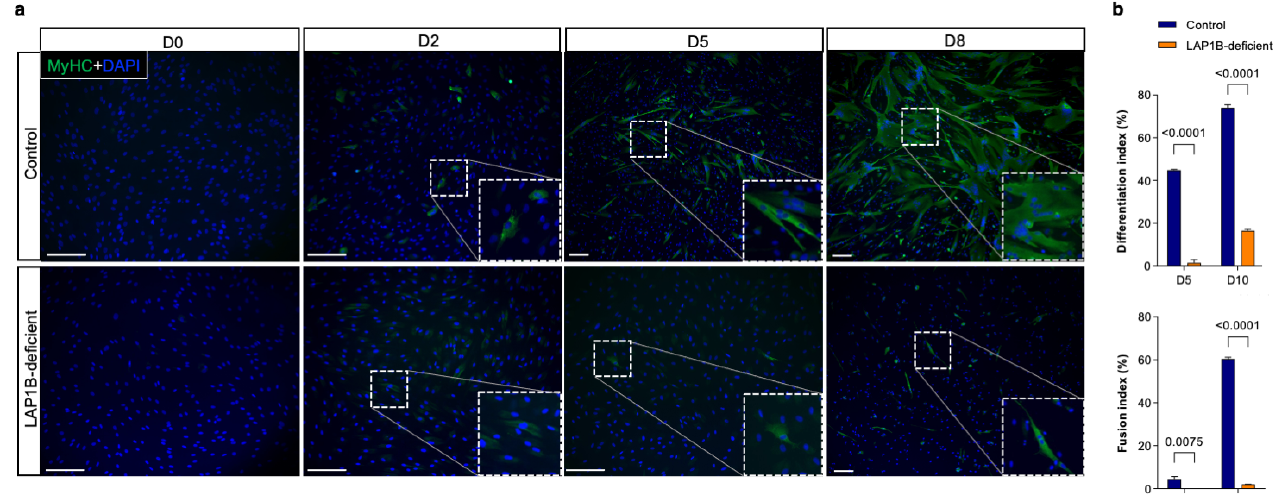
Figure 2. Myogenic differentiation of the control and patient-derived LAP1B-deficient fibroblasts. ( a ) Immunofluorescence staining of MyHC in the control and LAP1B-deficient cells at day 0 (D0), day 2 (D2), day 5 (D5), and day 8 (D8) after MyoD induction. The nuclei are stained with DAPI. The insets show MyHC-positive cells. Scale bar: 20 μ m. ( b ) Fusion index (percentage of nuclei in MyHC-positive cells with at least two nuclei relative to the total number of nuclei) and differentiation index (percentage of nuclei in MyHC-positive cells relative to the total number of nuclei) in the control and LAP1B-deficient cells at day 5 (D5) and day 10 (D10) of differentiation. n = 3, where n represents the number of independent experiments, and p -values were determined using a two-way ANOVA followed by Bonferroni post hoc tests.